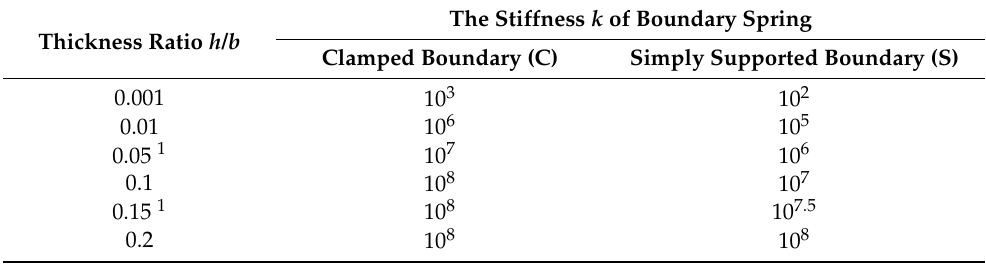
Table 3. Boundary spring stiffness for clamped and simply supported boundary.